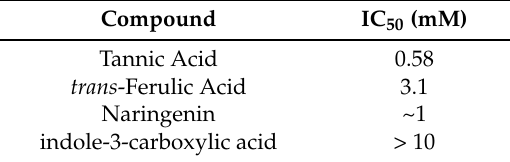
Table 1. IC 50 values for tested compounds determined against Fusarium graminearum cell